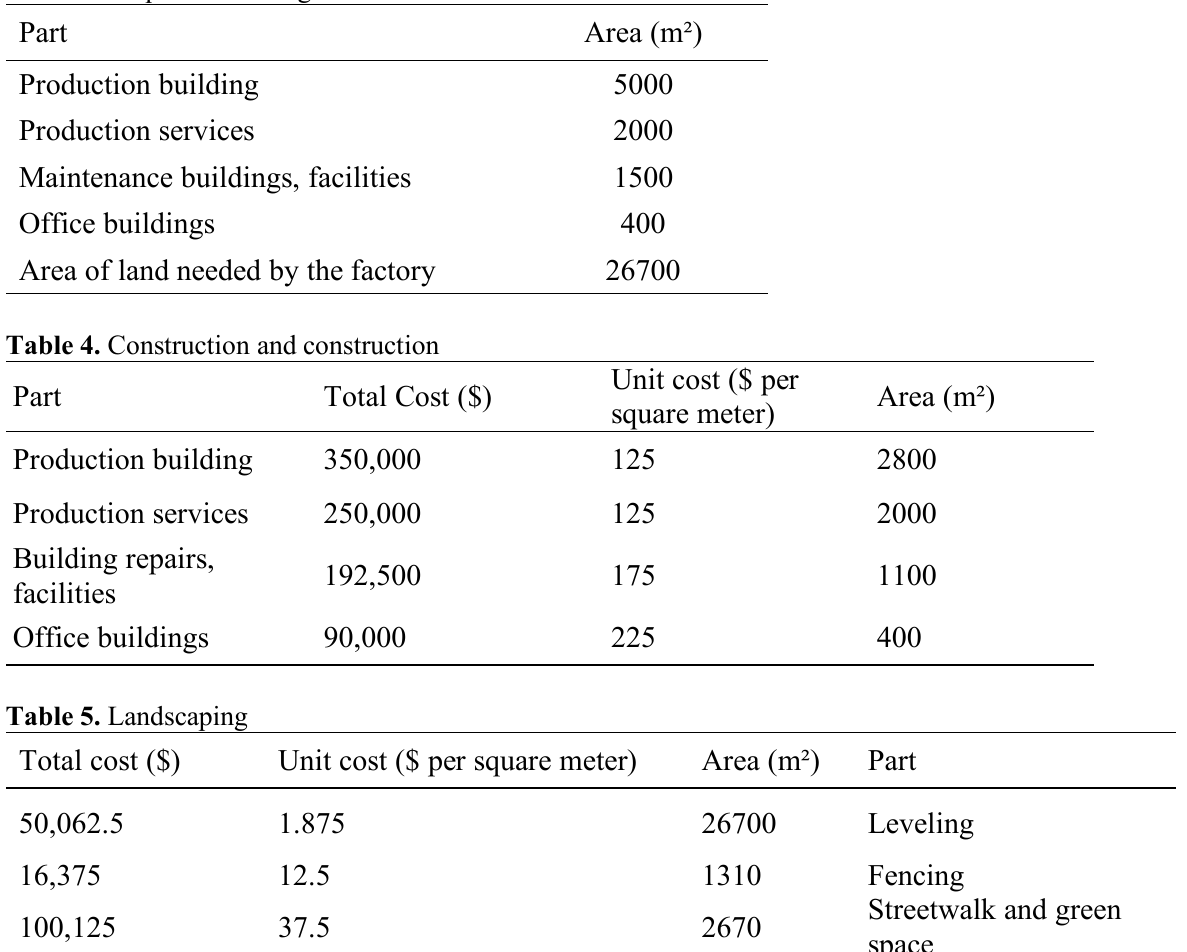
Table 3. Required Buildings’ Area